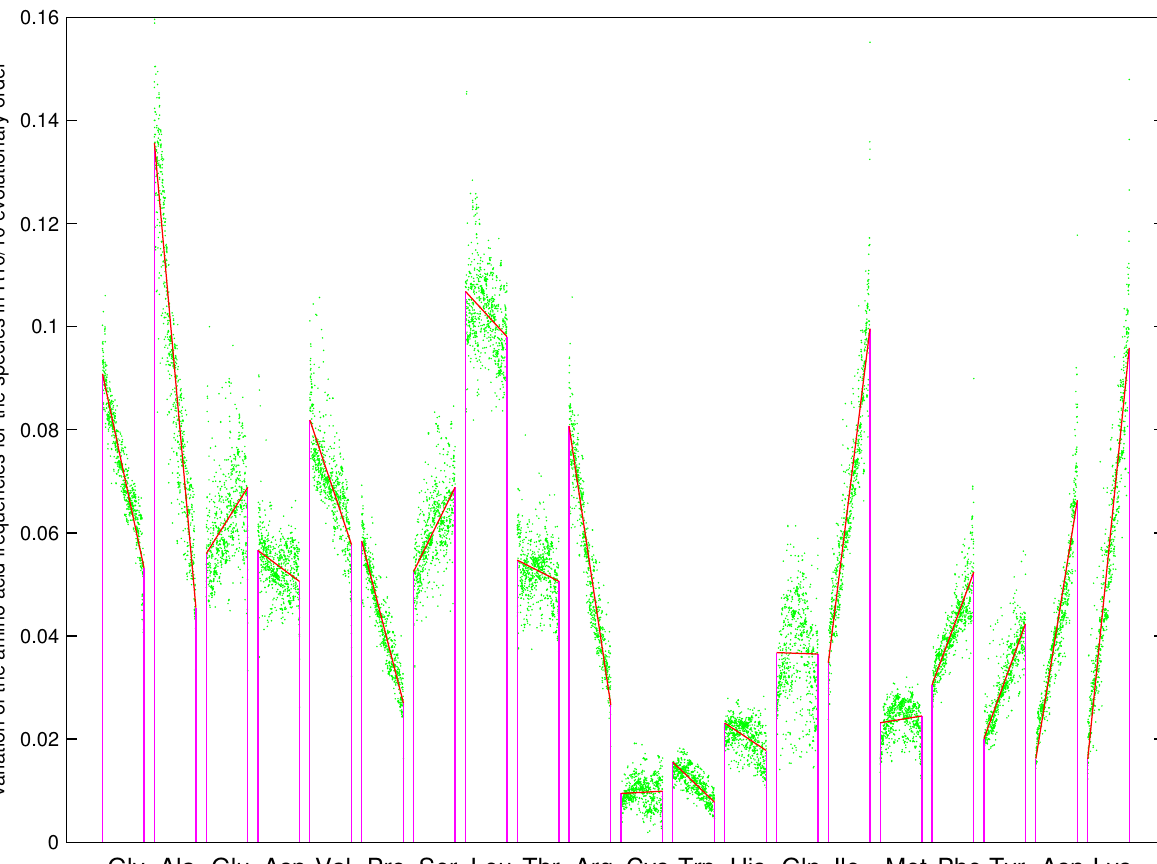
Figure 9. The recruitment orders of amino acids and codon pairs on the roadmap are supported by the variation of the amino acid frequencies. The 20 amino acids are arranged in the recruitment order on the roadmap Figure 1a. The 20 amino acid frequencies for each of the 803 species are obtained, respectively, based on the genomic data in NCBI. The 803 amino acid frequencies (green dots) for each of the 20 amino acids are all arranged properly in the R 10/10 order [36], respectively. The variation trend of the amino acid frequencies for each of the 20 amino acids is obtained by the regression line (denoted in red). Generally speaking, the variation trends for the earlier amino acids tend to decrease, and the variation trends for the latecomers to